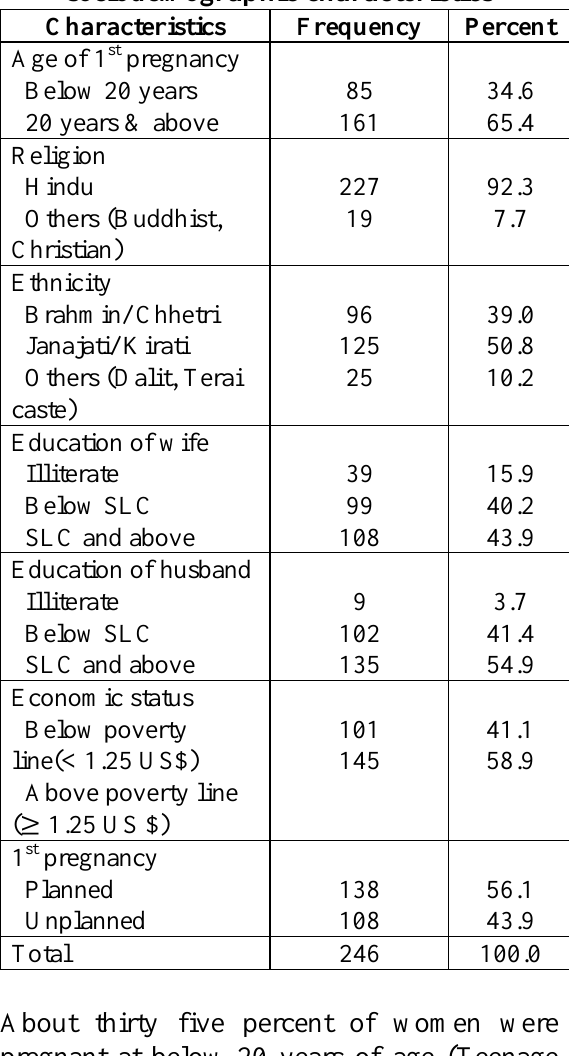
Table 1. Study population by